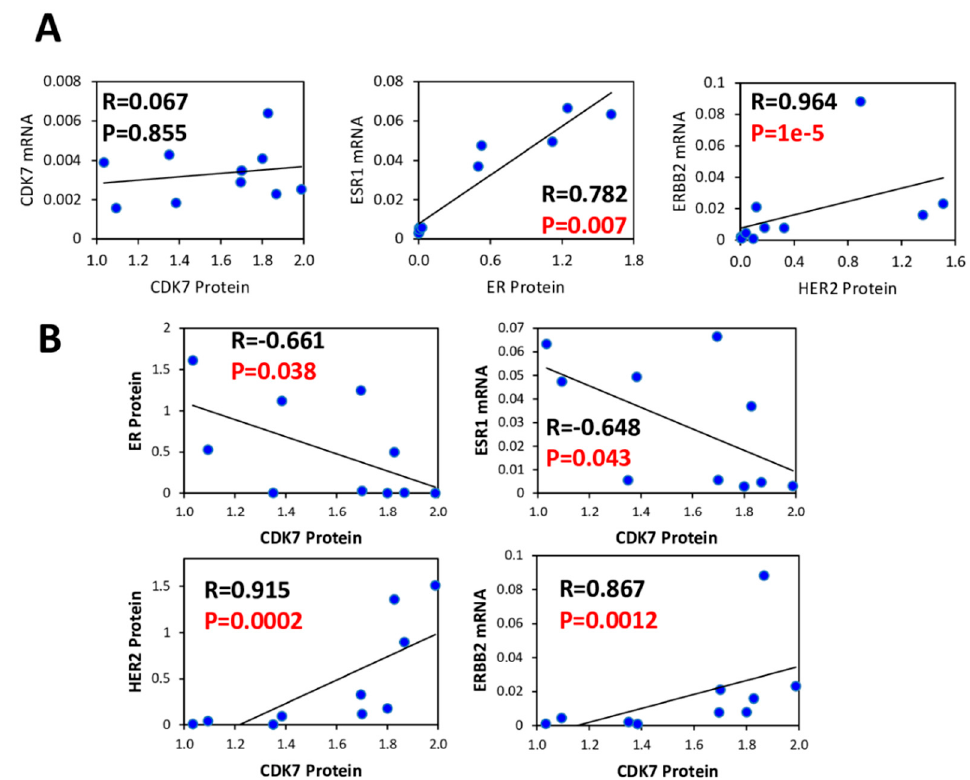
Figure 5. HER2 and ER are not markers of response to THZ1. ( A ) Bi-variant scattergraphs and Spearman rank correlations between CDK7, ER (ESR1) and HER2 (ERBB2) protein and mRNA expression levels ( B ) Bi-variant scattergraphs and Spearman rank correlations for CDK7 protein compared to protein and mRNA expression of ER (ESR1) or HER2 (ERBB2) across the cell line panel.